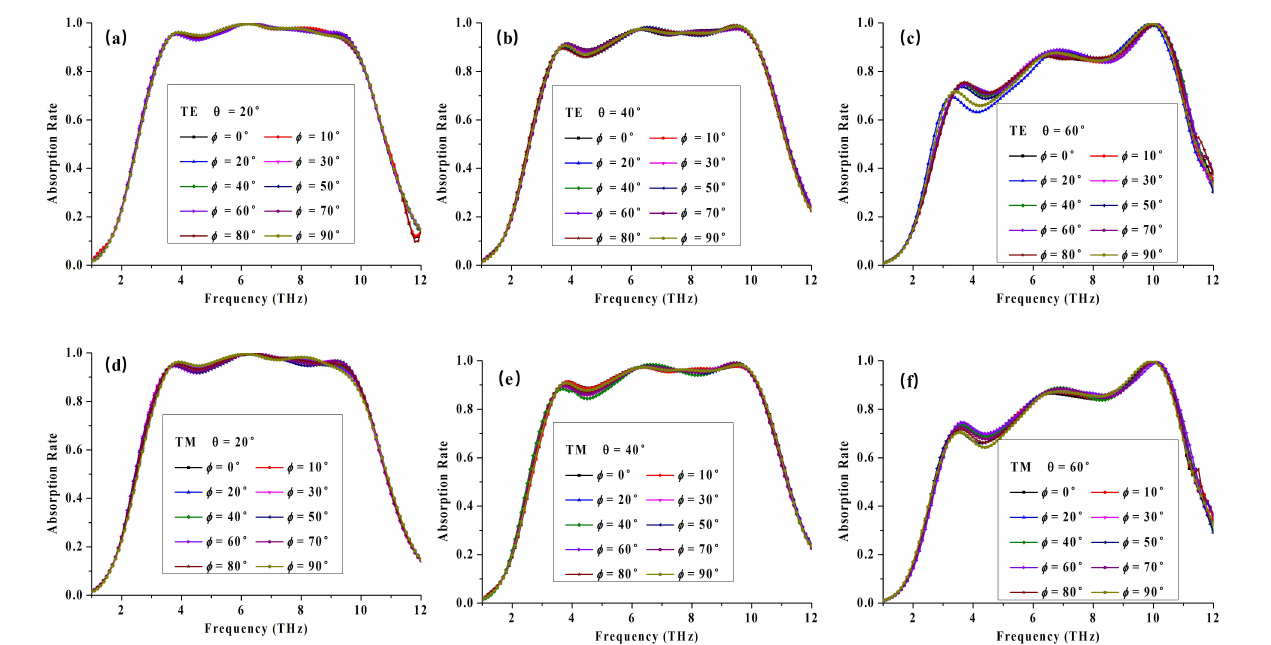
Figure 9. Simulated absorption spectra of the absorber for different polarization angles for TE mode under incident angle of ( a ) 20 ◦ , ( b ) 40 ◦ , ( c ) 60 ◦ , and for TM mode under incident angle of ( d ) 20 ◦ , ( e ) 40 ◦ , ( f ) 60 ◦